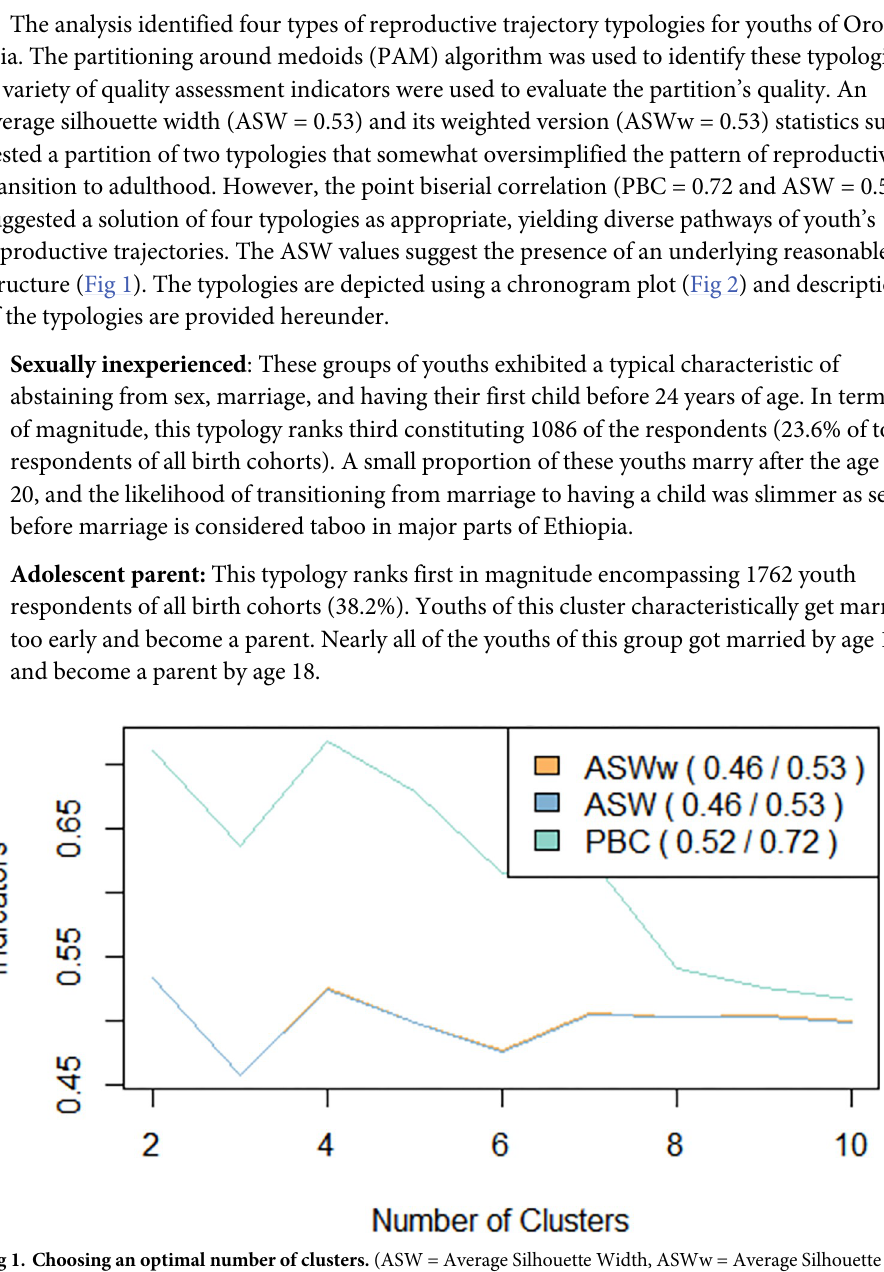
The analysis identified four types of reproductive trajectory typologies for youths of Oro- mia. The partitioning around medoids (PAM) algorithm was used to identify these typologies.